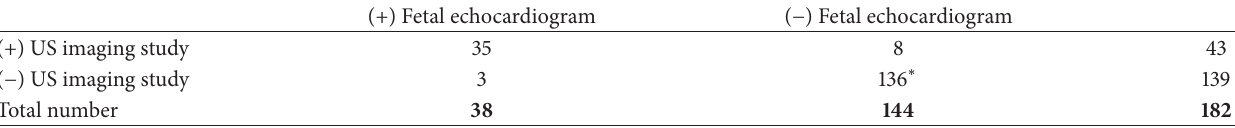
Table 5: Presence (+) or absence ( − ) of cardiac abnormality by test: fetal echocardiogram performed by MFM versus pediatric cardiologists. (+) Fetal